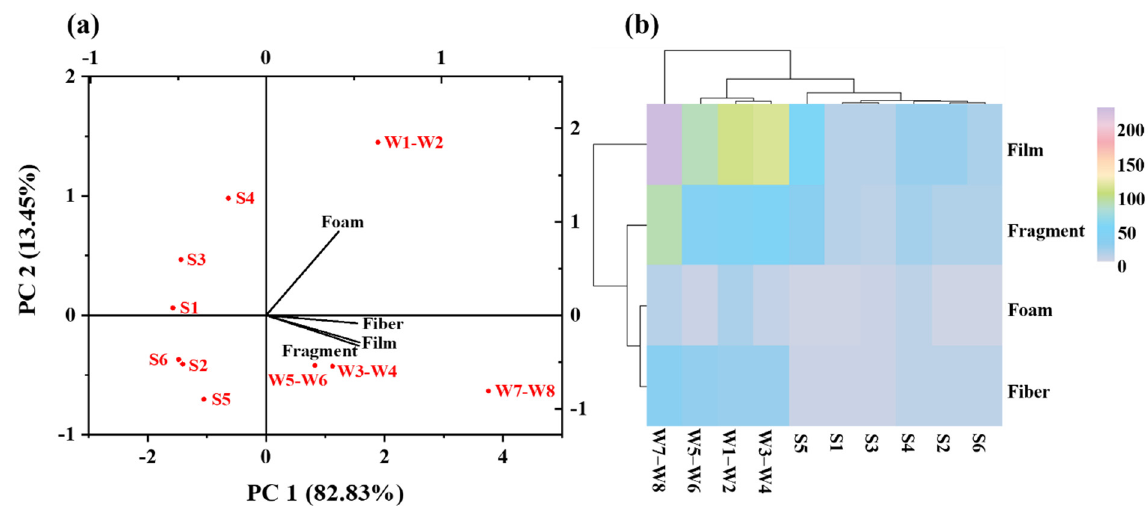
Figure 7. An analysis of microplastic species, using principal components ( a ) and a heat map ( b ) to cluster sampling sites in the Songshan Lake Basin, based on the shape distribution of the microplas- tics.